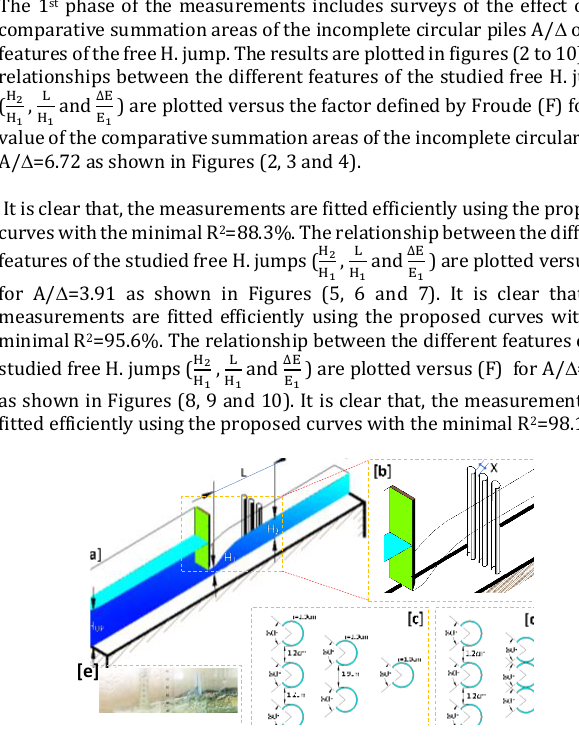
Figure 8: The relationship between 𝐻 2 and F 𝐻 1 for A/  =2.44